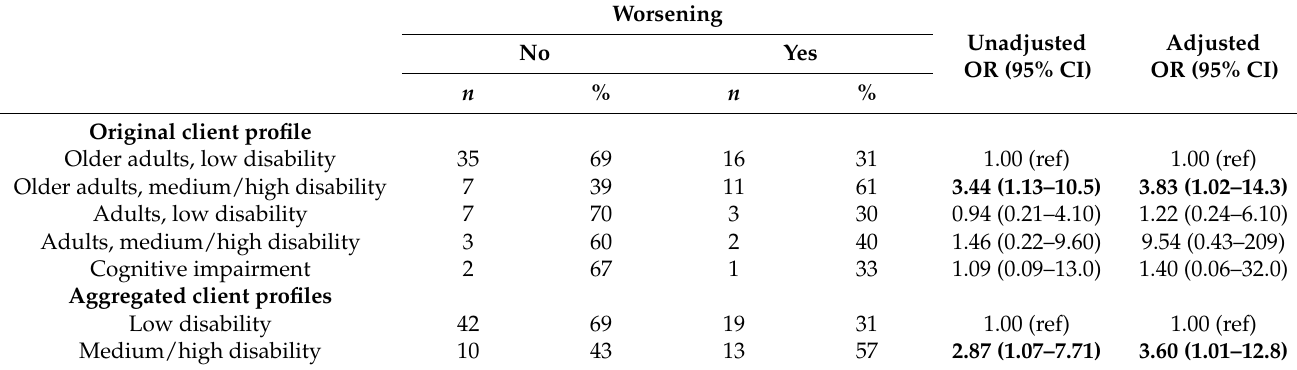
Table 5. Odds ratios (ORs) with 95% confidence intervals (CIs) for worsening of fall history during one year after HA.